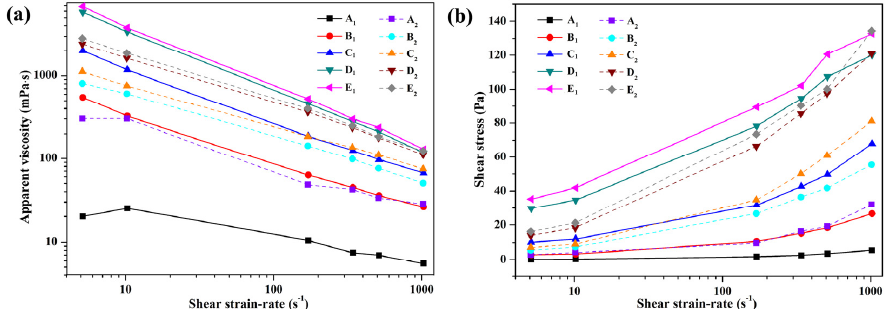
Figure 5. Apparent viscosity as a function of shear rate ( a ), and flow curves ( b ) of base fluid containing different concen- trations of PADAD before (A 1 -E 1 ) and after aging (A 2 -E 2 ).